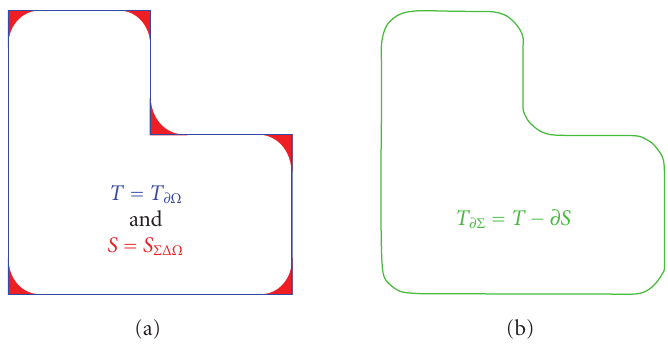
Figure 3.2. A simple reinterpretation of the L 1 TV input and minimizer gives us the flat norm of T ∂ Ω and the decomposition into the diminished boundary T ∂ Σ and the symmetric di ff erence current S Σ (cid:2) Ω